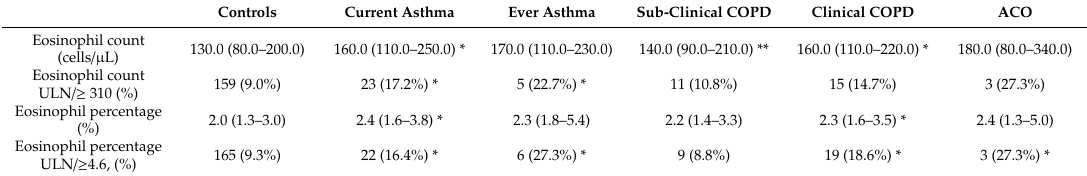
Table 2. Eosinophilic inflammation in subjects in the Asklepios Study.